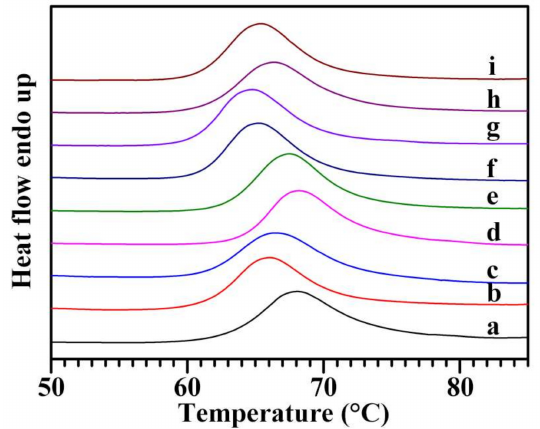
Figure 6. DSC thermographs of starches from variety 3113 ( a ), Benlizi ( b ), Dahongpao ( c ), Erqingzao ( d ), Heishanzhai 7 ( e ), Mi 5 ( f ), Mi 6 ( g ), Yangguang ( h ), and Yanshanhong ( i